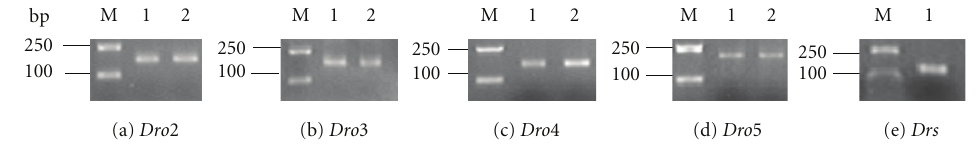
Figure 2: Detection of 5 (cid:2) RACE products of drosomycin genes . The fragments were visualized by staining with ethidium bromide after separation in 2% agarose gel. M. DNA marker. Both lanes 1 and 2 were the 5 (cid:2) RACE PCR products.